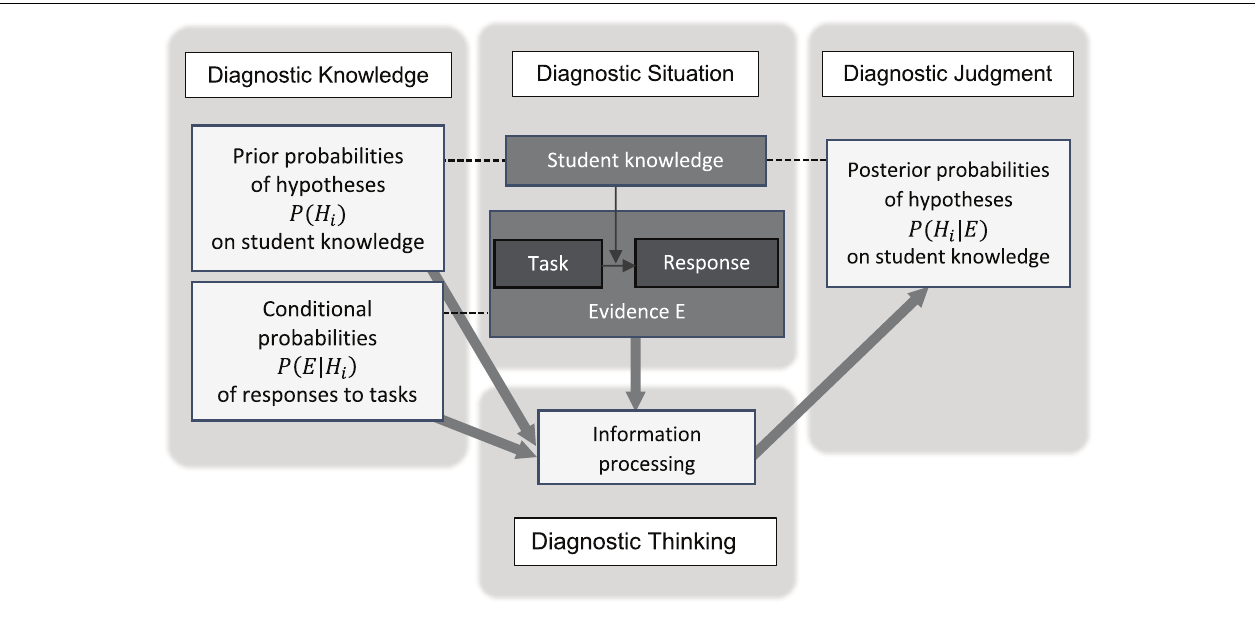
FIGURE 1 | The structure of teacher’s diagnostic judgment based on knowledge, evidence, and information processing and the role of